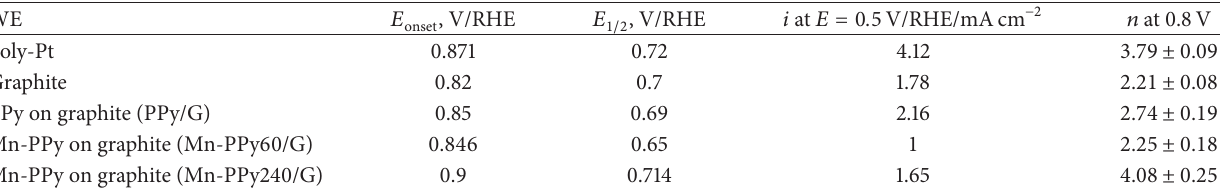
Figure9:(a)RDEvoltammograms(scanrate:5mVs −1 )ofMn-PPy240/GcatalystinO 2 -saturated0.1MKOHatdifferentrotationspeeds.The N 2 background has been subtracted. (b) Koutecky–Levich plots derived from the curves of Panel (a) at a series of representative potentials. Symbols are experimental data; lines are the linear regressions. (c) Dependence of the electron transfer number 𝑛 on the electrode potential for three replicated samples. (d) Tafel plot obtained from RDE voltammograms at 1600 rpm. Table 3: ORR electrocatalytic parameters of graphite, PPy, and Mn/PPy catalysts obtained by RDE voltammograms (scan rate: 5 mVs −1 ) in O 2 -saturated 0.1 M KOH at 1600